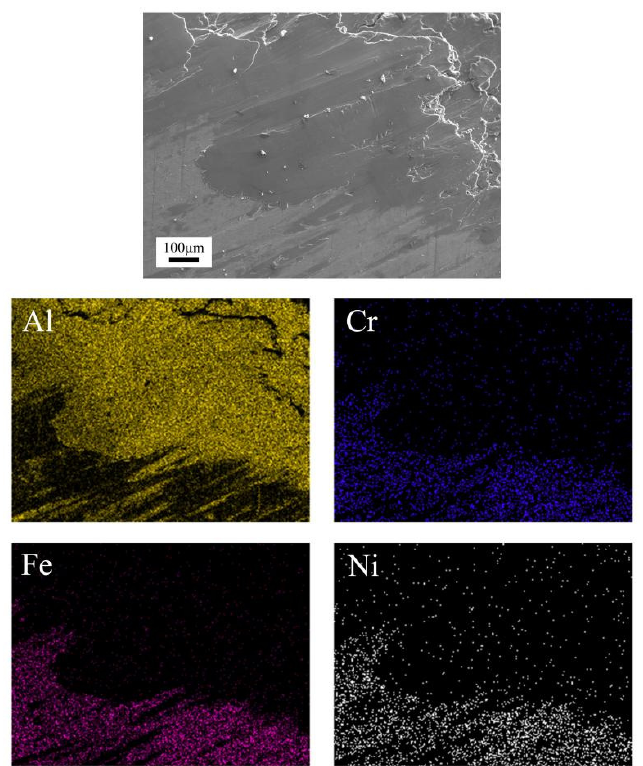
Figure 15. Multi-layer transferred aluminum alloy on the TN10.